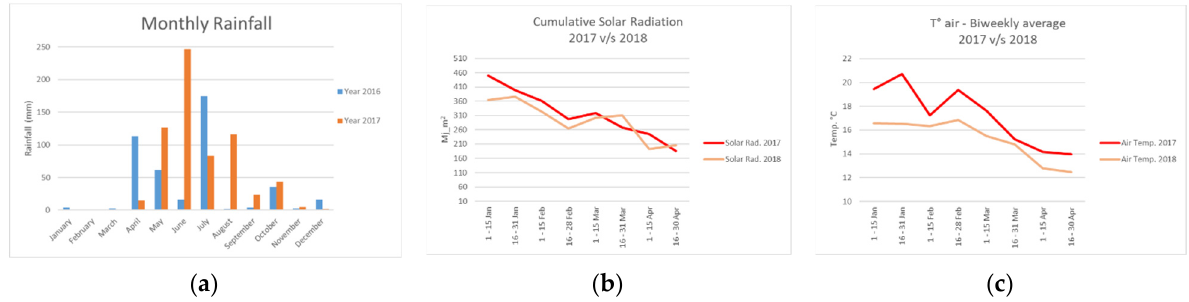
Figure 2. Climatic variables for seasons 2017 and 2018: ( a ) Cumulative rainfall graph for both seasons; ( b ) solar radiation graph for both seasons; ( c ) biweekly average air temperature for both seasons.